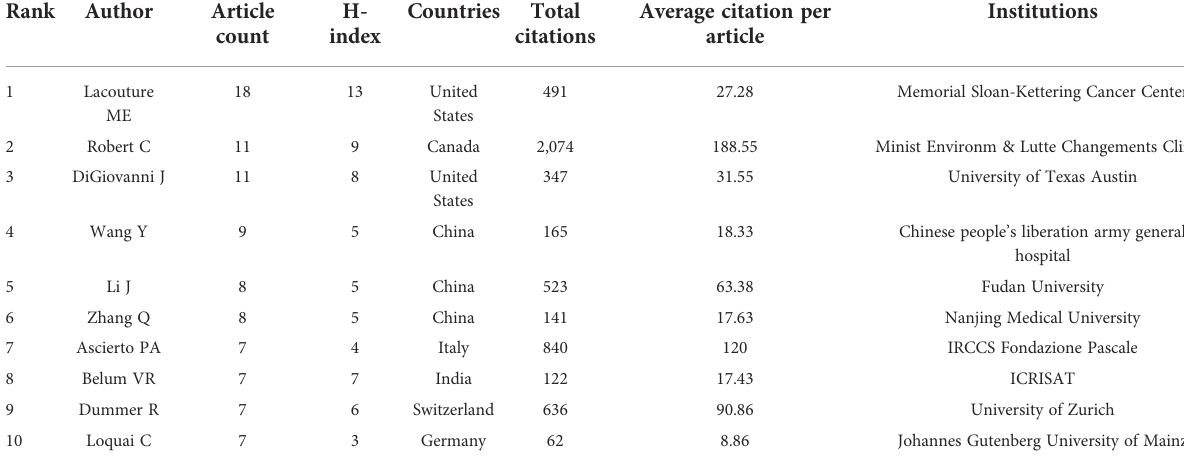
Figure 8B, the occurrence of keywords has changed from blue to red color over time, indicating that research hotspots related to Melanoma and Immunotherapy have emerged in recent